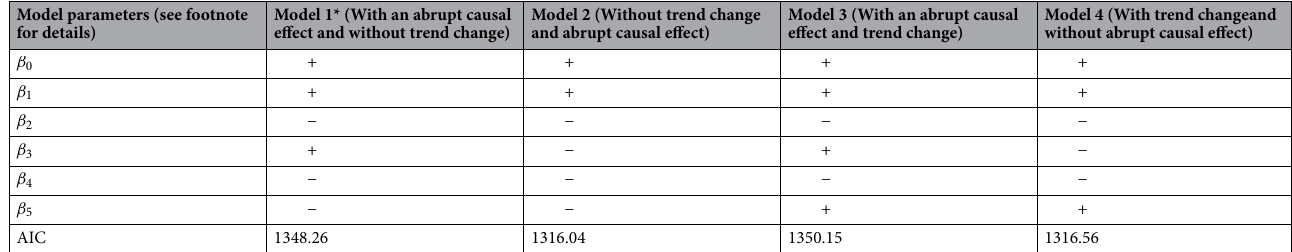
Table 4. Comparison of models that capture the time-dependent variations in the case fatality risk of COVID- 19 in other than seven prefectures in Japan. Plus shows what was accounted for, and minus that this was not included in that model. β 0 is the parameter for the baseline level; β 1 , the increase in the outcome following the time-unit increase; β 2 and β 3 , the change in the level at first and second interventions (7 April and 8 May 2020, respectively); and β 4 and β 5 , the change in trend following first and second intervention (7 April and 8 May 2020, respectively). Seven prefectures include Tokyo, Kanagawa, Saitama, Chiba, Osaka, Hyogo, and Fukuoka.